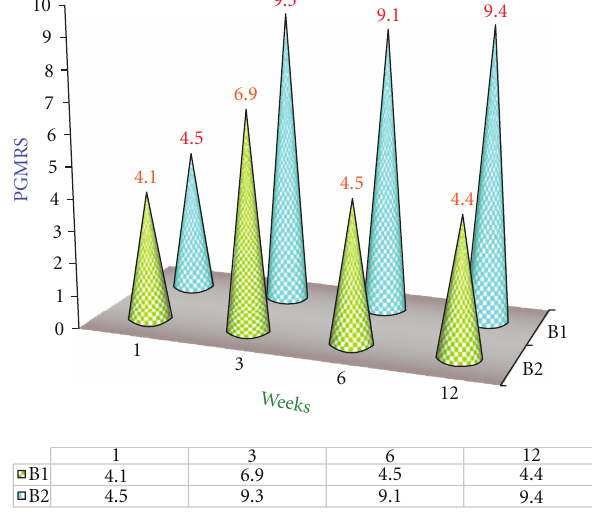
Figure 7: Comparison of mean position of gingival margin from reference stent (PGMRS) of B1 and B2 Groups.